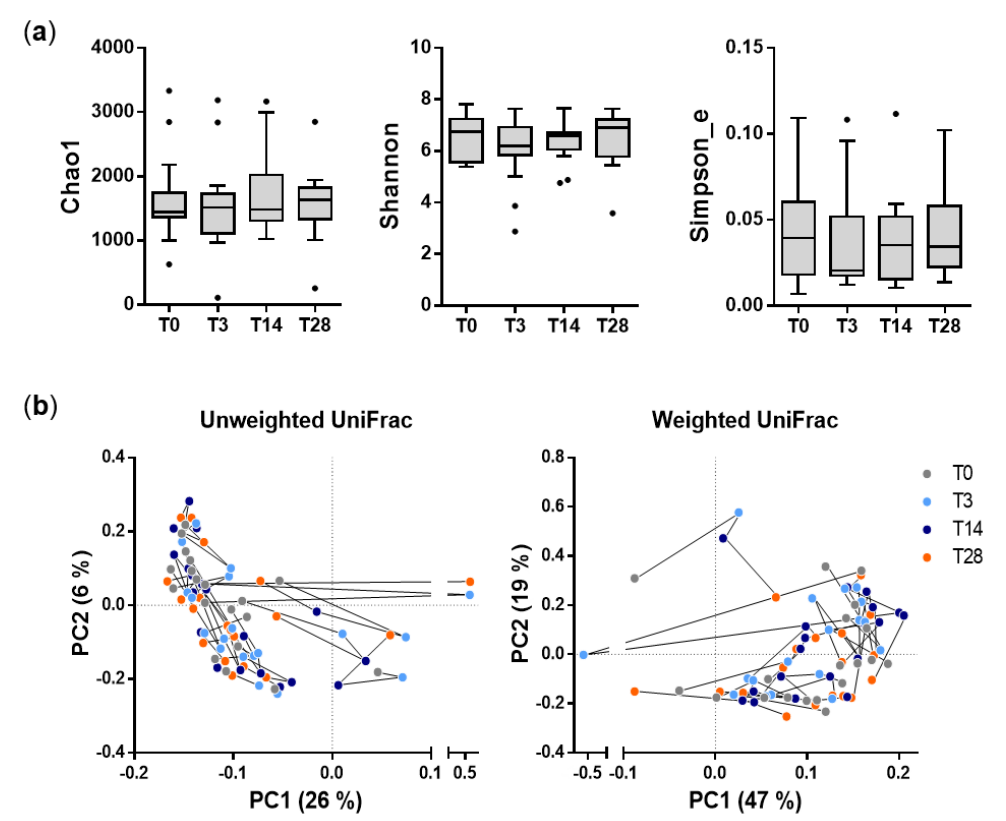
Figure 2. Diversity analysis of fecal bacterial communities during the probiotic intervention trial. ( a ) α -diversity analysis; the panel shows three indexes that differently describe the richness and evenness of bacterial communities in fecal samples. ( b ) β -diversity analysis based on principal coordinate analysis of unweighted (left) and weighted (right) UniFrac distances. Each point in the graph represents a different fecal sample. Colors indicate the different phases of the study, according to the legend on the right. Black lines connect samples from the same subject. The percentages indicate the proportions of variance explained by the first and second ordination axes.